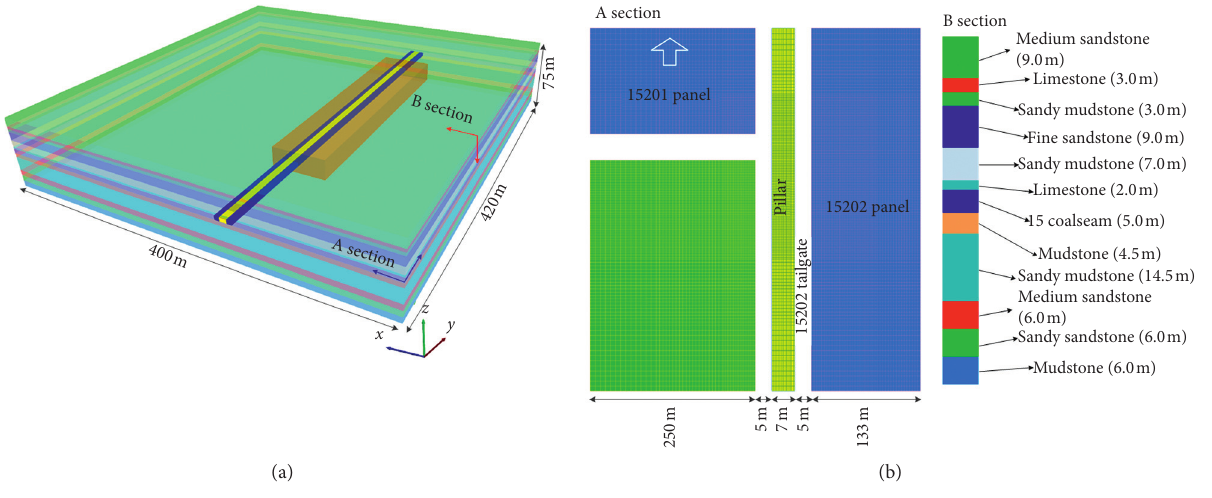
Figure 7: Schematic diagram of the FLAC 3D numerical model.